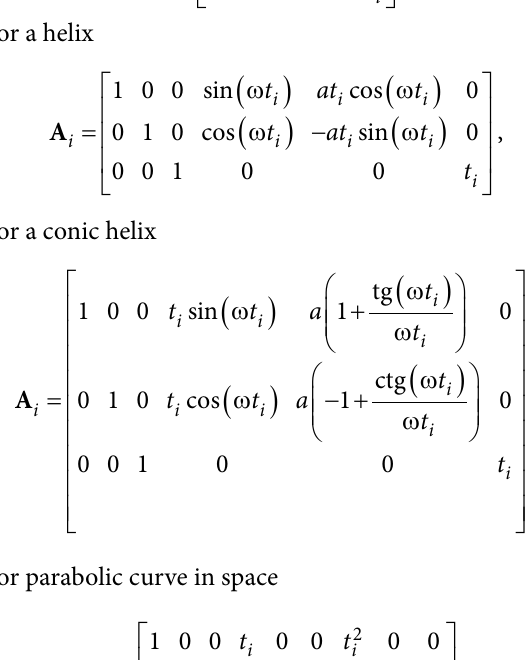
Fig. 5. The displacements of the reflectors in the direction of the cross axis for the south-east